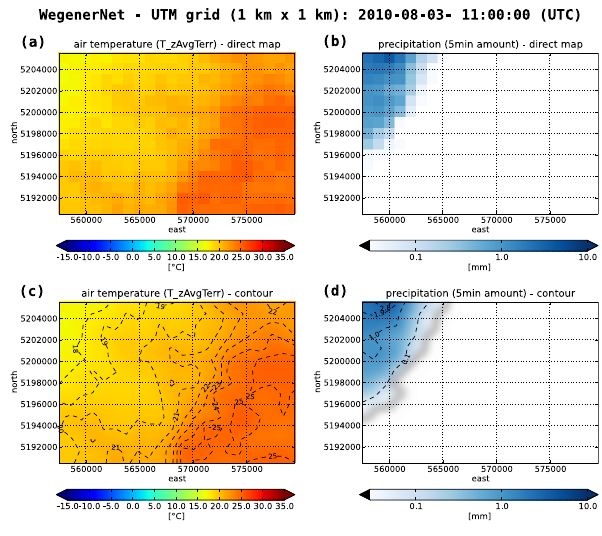
Figure 3. Temperature and precipitation conditions on August 3, 2010, in the WegenerNet region at 1km resolution in UTM coordi- nates (dotted lines): direct map of grid cells in (a) and (b) , smoothed cell boundaries and inserted contours (dashed lines) in (c) and (d) . Precipitation amounts (5min) are given on a logarithmic